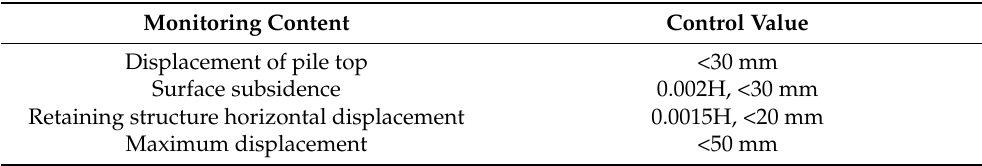
Table 3. Deformation control values of